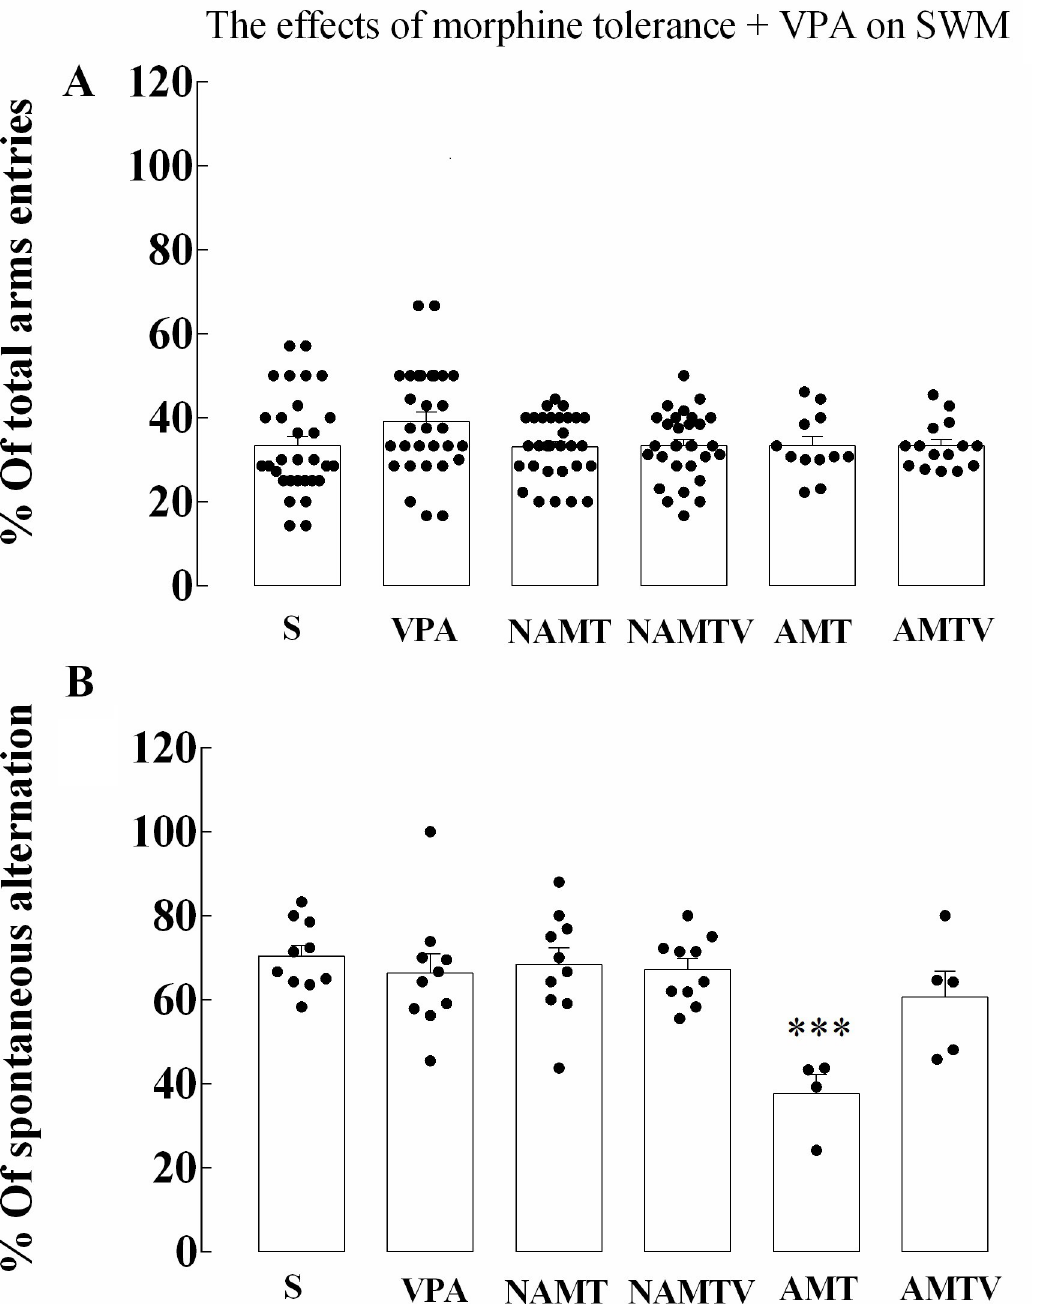
Fig 4. The effect of the expression of morphine tolerance and valproic acid pre-treatment on spatial working memory. (A-B) No significant difference was detected in the total number of arm entries, which was used as the index of locomotor activity. However, %Spontaneous alternation in the Y-maze task decreased in AMT. Data has been shown as mean ± SEM, ��� p < 0.001 compared with control group (one-way ANOVA followed by Tukey’s multiple comparisons test). SWM, S, VPA, NAMT, NAMTV, AMT, and AMTV stand for spatial working memory, saline, valproic acid, non-associative morphine tolerance, non- associative morphine tolerance + valproic acid, associative morphine tolerance, and associative morphine tolerance + valproic acid,